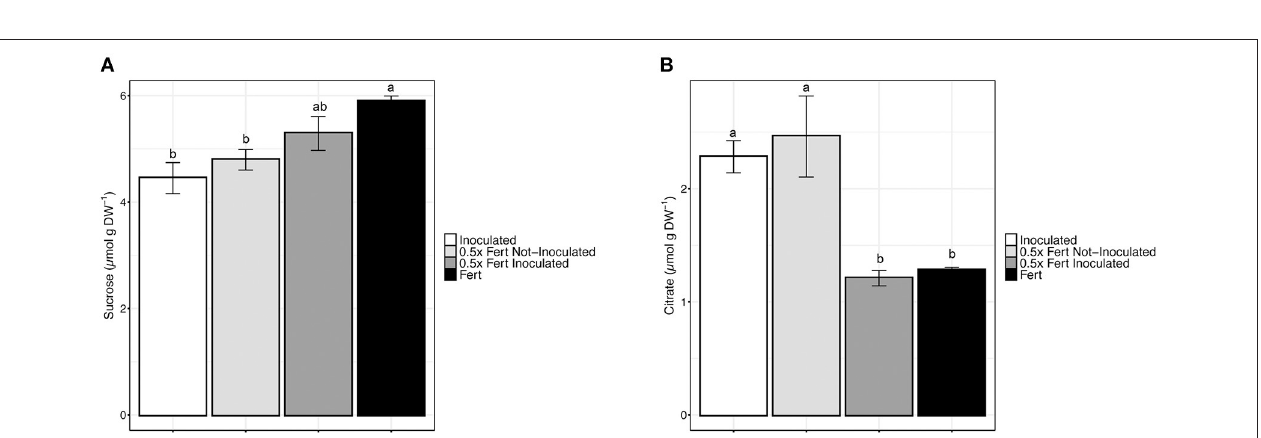
FIGURE 5 | Principal Component Analyses of fruit ionome signature . Scatterplot representing the modification of cucumber fruit ionome harvested from plants cultivated for 60 days in greenhouse and subjected to the different fertilization treatments (i.e., Inoculated, 0.5x Fert Not-Inoculated, 0.5x Fert Inoculated, and Fert).